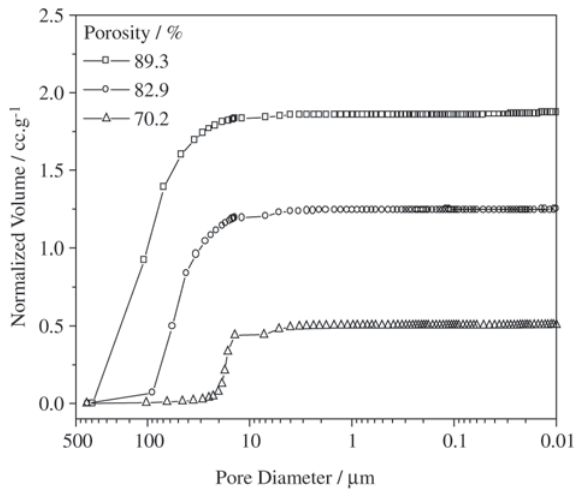
Figure 2. Mercury porosimetry intrusion curves for three differ- ent foam densities.